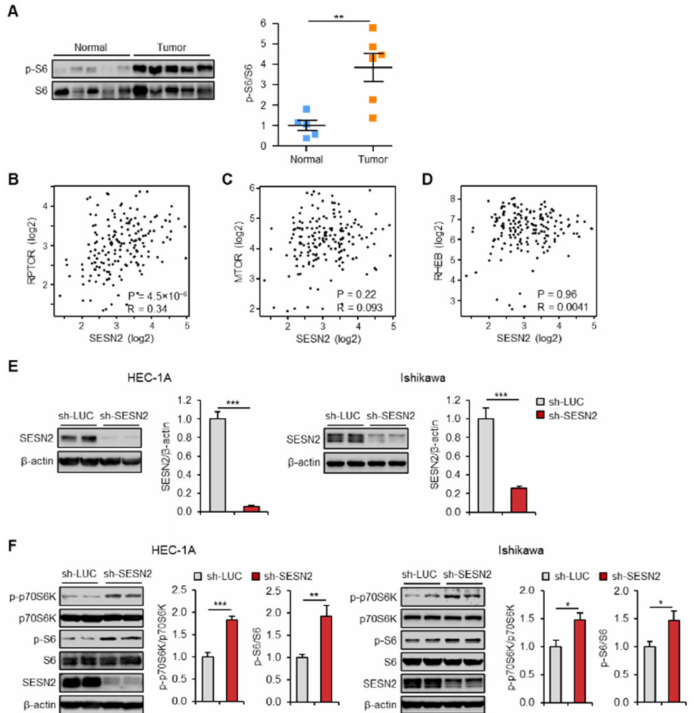
Figure 2. Correlation of expression of SESN2 with the mTOR pathway in endometrial cancer. ( A ) Immunoblot analysis of p-S6 in endometrial cancer ( n = 6) and normal endometrium ( n = 5). S6 served as a loading control. Band intensities are quantified and normalized with S6 values. ( B – D ) Correlation between SESN2 RNA expression and with those of mTOR pathway-related markers, including regulatory associated protein of mTOR ( RPTOR ) ( B ), MTOR ( C ), and RHEB ( D ), in endometrial cancer analyzed using the GEPIA database. The correlation coe ffi cients were calculated using Spearman’s test. ( E ) Immunoblotting analysis of SESN2 in HEC-1A and Ishikawa cells infected with lentiviruses expressing shRNAs targeting luciferase (sh- LUC ) or SESN2 (sh- SESN2 ). Cell lysates were immunoblotted with anti-SESN2 antibody. β -actin served as a loading control. Band intensities are quantified and normalized over the β -actin values. ( F ) Immunoblotting analysis of phospho-p70 ribosomal protein S6 kinase (p-p70S6K), p70S6K, p-S6, and p6 in HEC-1A and Ishikawa cells were infected with sh- LUC or sh- SESN2 . Cell lysates were immunoblotted with anti-p-p70S6K, anti-p70S6K, anti-p-S6, and anti-S6 antibodies. β -actin served as a loading control. Band intensities were quantified and normalized with p70S6K or S6 values. Data are shown as mean ± SEM. Results are representative of at least three independent experiments. * p < 0.05; ** p < 0.01; *** p < 0.001 (Student’s t